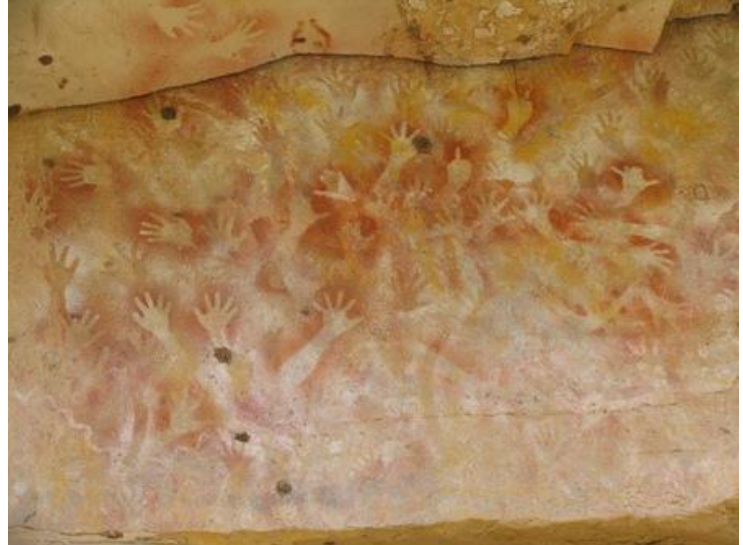
Figure 10. Candidate stencils for transposed gestural signs, Central Queensland Sandstone Belt, Australia. Courtesy C.